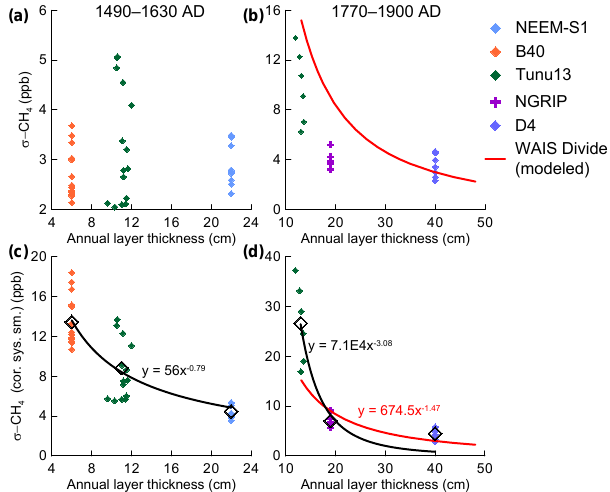
Figure 6. Relationship between accumulation rate and high- frequency CH 4 variability. The vertical panels represent two time intervals: 1490–1630 AD (a) and 1770–1900 AD (b) for which high-resolution CH 4 data are available from three ice cores with different accumulation rates. Note that the three clusters of data points for each time period do not represent the same ice cores in each case. The top row (a, b) displays ( σ ) − CH 4 calculated ev- ery 10years for intervals of 40years duration as Fig. 5 (except for NGRIP data points on (b, d) that represent discrete 10-year inter- vals). The bottom row (c, d) displays σ -CH 4 values adjusted (in- creased by 1.25–5 depending on ice core) to correct for the damp- ing effect of the continuous analytical system (Fig. S2). Mean val- ues for each ice core on each panel are displayed (black diamonds) with power law relationships (black line). Also shown is the rela- tionship between accumulation rate and σ -CH 4 for WAIS Divide (at 2.5ppbyr − 1 atmospheric growth rate) as predicted by the CIC firn air transport